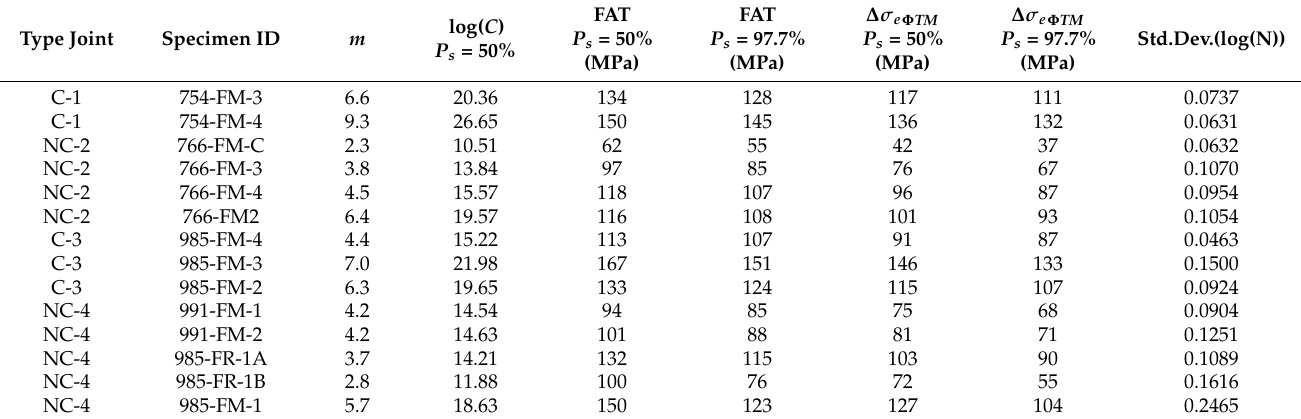
Table 6. S-N curve parameters predicted by energy